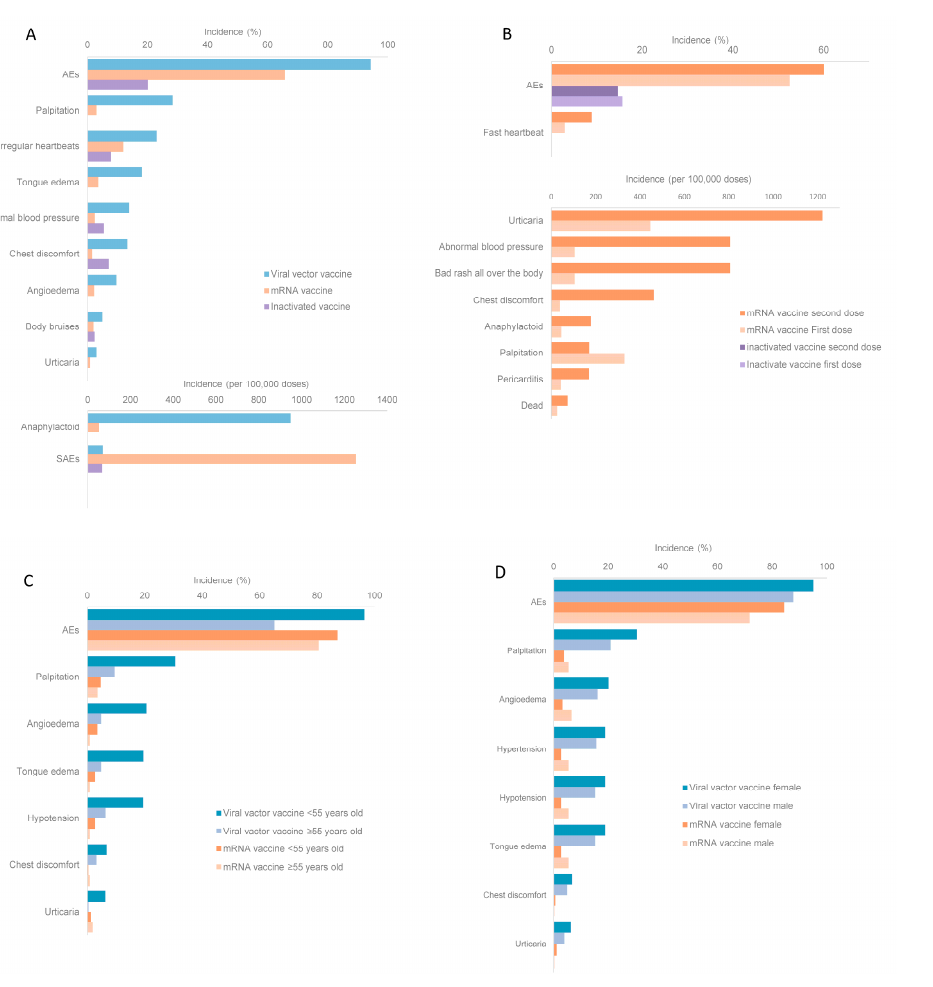
Figure 4. The incidence of adverse events (AEs) of different vaccines and population . ( A ) The incidence of AEs of different vaccines; ( B ) the incidence of dose-specific AEs with mRNA vaccine or inactivated vaccine inoculation; ( C ) the incidence of age-specific AEs with viral vector vaccine or mRNA vaccine inoculation; and ( D ) the incidence of gender-specific AEs with inactivated vaccine